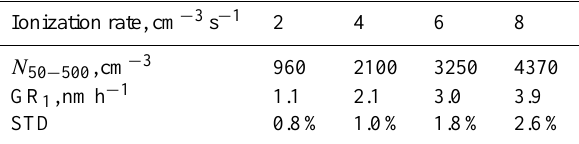
Table 2. Estimates of the background aerosol particle number con- centration N 50 − 500 and the growth rate of nanoparticles according to Eqs. (7)–(10) at constraints GR 0 (3nm)=GR 0 (7nm)=GR 1 and c =450 cm − 3 depending on the trial value of ionization rate. STD is the standard deviation of difference (GR 0 /GR 1 – 1) in the range of diameters of